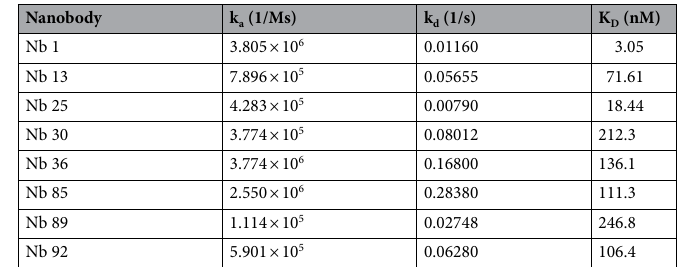
Table 1. Kinetic constants of the selected Nbs. Kinetic rate constants of association (k a ), and dissociation (k d ), and the corresponding equilibrium dissociation constants (K D ) of the selected Nanobodies against MRCV P9-1 viroplasm protein as determined by SPR.